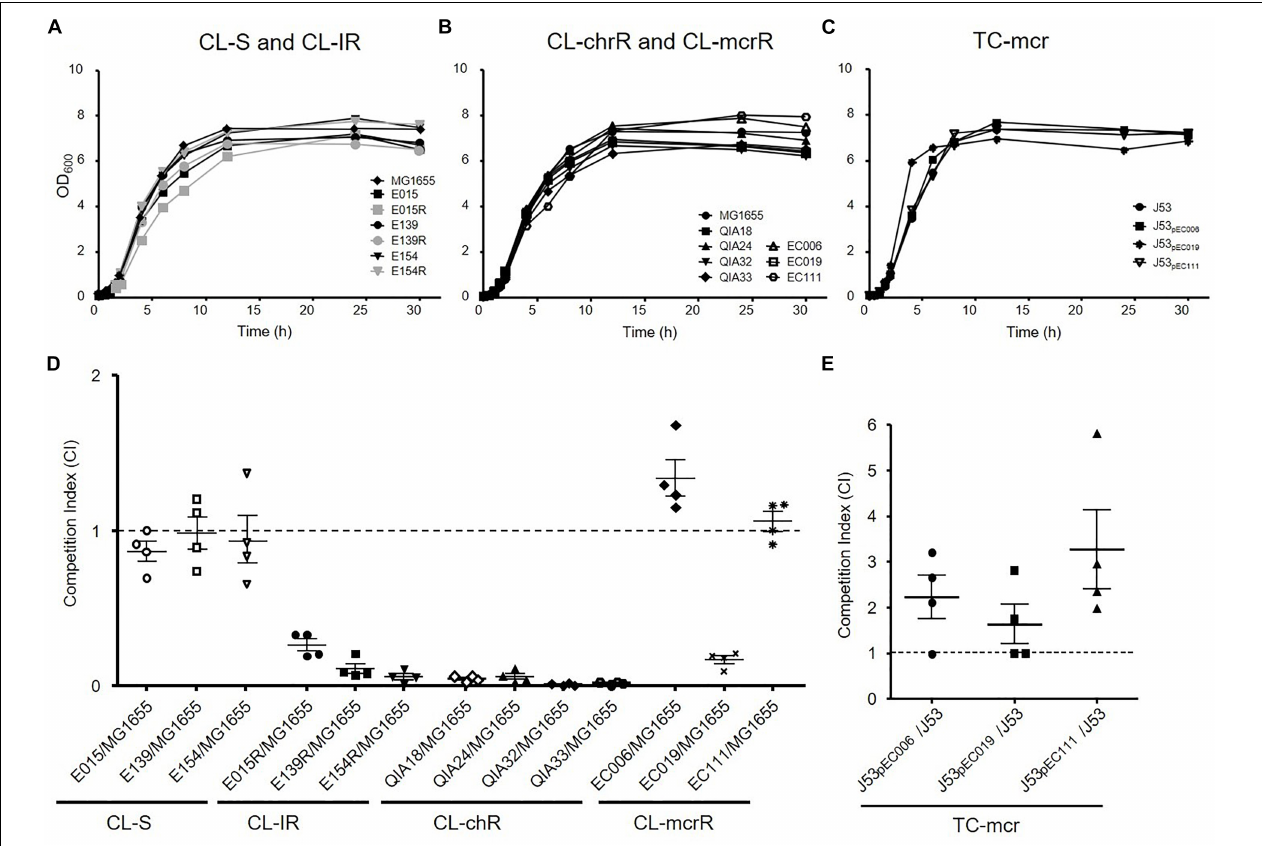
FIGURE 3 | Growth rates and fitness cost. (A–C) Growth curves of CL-S, CL-IR, CL-chrR, CL-mcrR, and TC-mcr strains. y axis, optical densities (OD) of broth cultures at 600 nm; x axis, time of growth (hours). (D) In vitro competitive fitness of CL-S, CL-IR, CL-chrR, and CL-mcrR strains, which were competed with a reference E. coli strain MG1655. While CL-S strains were differentiated from MG1655 in MH agar with or without ampicillin (100 mg/L), the others were in agar with or without colistin (4 mg/L). (E) Competitive fitness of three transconjugants (TC-mcr strains), which competed with their recipient strain, J53. A CI value less than 1 indicates a fitness defect, and a value greater than 1 indicates a fitness benefit. The error bars indicate the standard